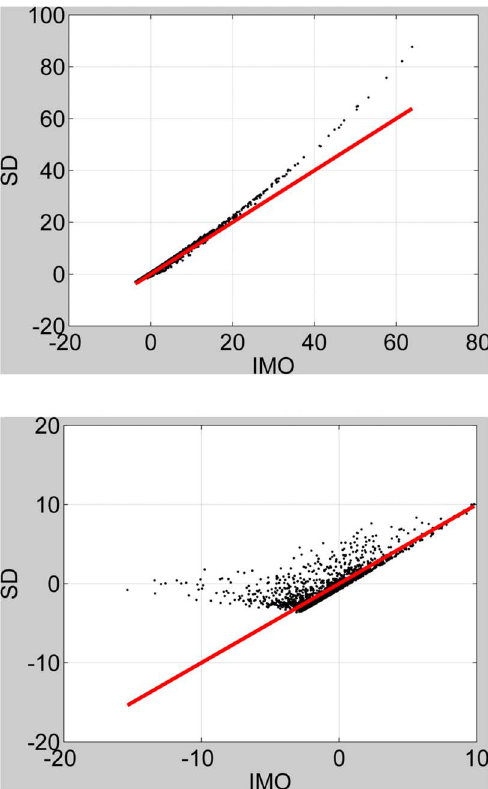
Figure 7. First-level models. Top Panel: log Bayes factor for SDT versus IMO approaches testing for any response to non-familiar faces. The red line denotes equality. Bottom Panel: log Bayes factor for SDT versus IMO approaches testing for main effect of familiarity